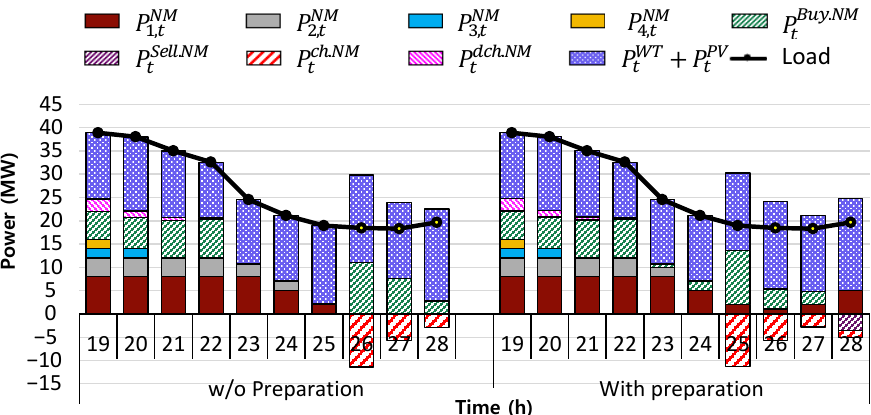
Figure 8. Pre-event MG operation without and with preparation in Case 2.